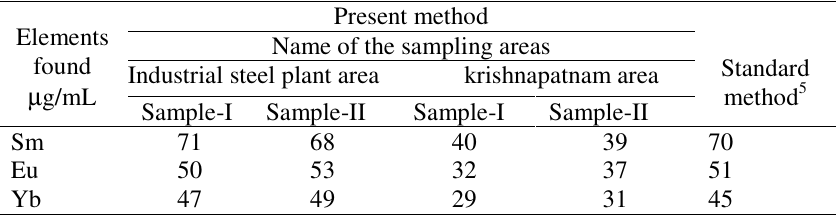
Table 1. Metal ions of analytical result in natural water samples.